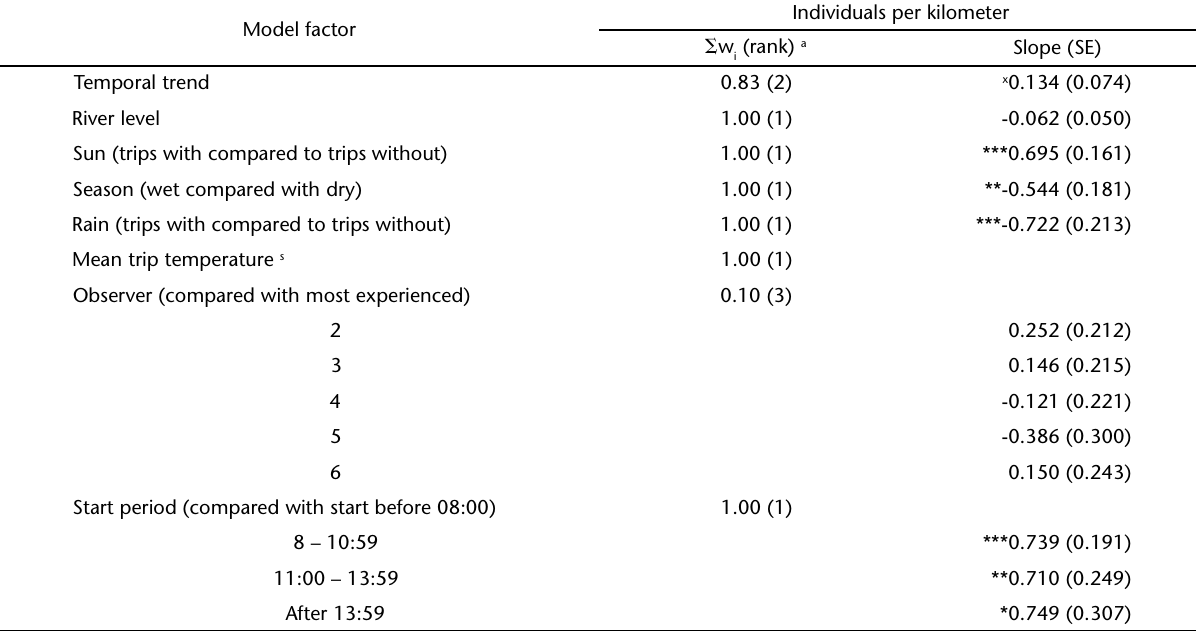
Table II. Model weights and parameter (slope) estimates from information-theoretic analysis of predictors of the occurrence of P. unifilis monitored during four years of boat surveys. Generalized additive models were used to predict the abundance (individuals per km) recorded during 333 trips around the Los Amigos Biological Station, Amazonian Peru.